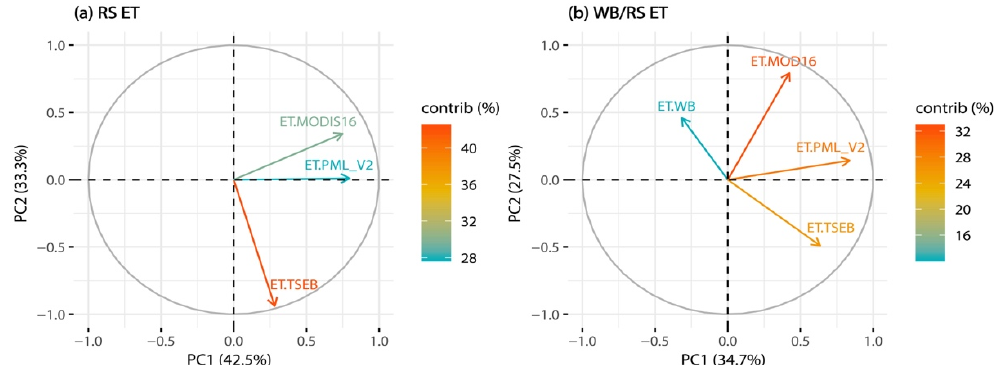
Figure 11. Principal component analysis PCA-based ET similarity assessment: inter-correlations between RS ET algorithms ( a ) and WB/RS ET products ( b ). The sample size is 20,654 (146) data tuples in a (in b ) panel for the ET datasets.